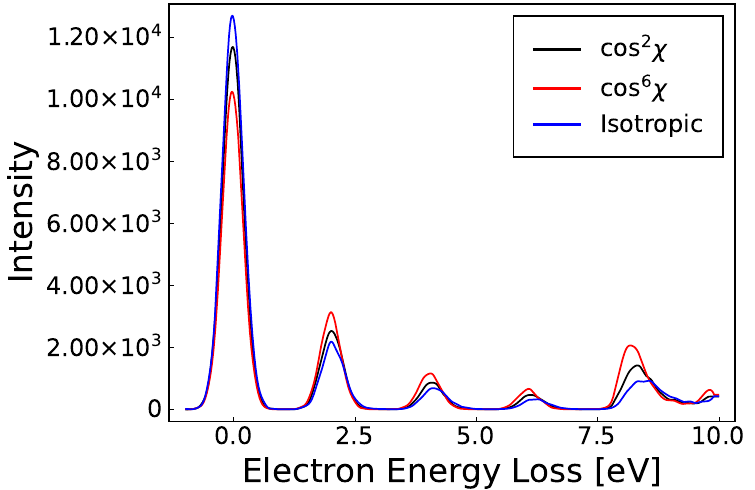
Figure A8. Elastic and inelastic EELS, with a varying differential cross-section. An initial energy of 10 eV is used with an inelastic threshold of 2 eV. Each DCS is represented using a normalised power of cos ( χ ) , as indicated in the legend. For higher degrees of forward scattering, a decrease/increase was observed at lower/higher energy